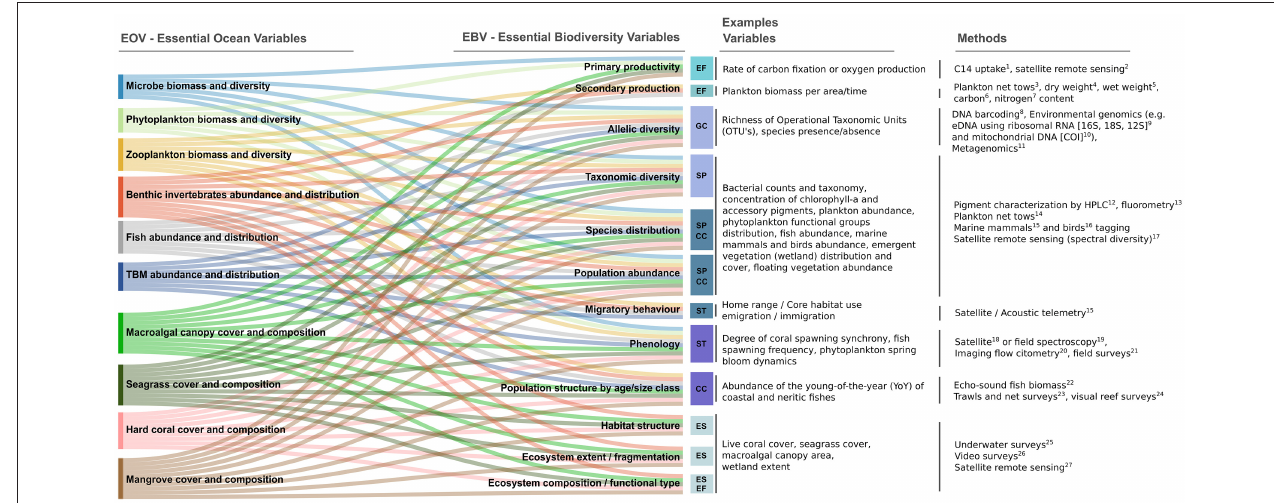
FIGURE 1 | Conceptual relationship between EOVs and EBVs, with simple examples. EOVs (listed on the left hand side) are broadly taxonomically focused around productivity at the base of the food chain (microbes, phytoplankton and zooplankton), higher trophic levels (benthic invertebrates; fish; TBM: marine turtles, birds, and mammals), and habitat forming species (macroalgae, seagrass, mangrove, coral). In contrast, example EBVs (listed on the left hand column) evaluate taxa across scales of spatial and temporal diversity within species (allelic diversity, species distribution, population abundance, population structure by age/size class, phenology), across species (taxonomic diversity), and in terms of ecological context (primary productivity, secondary productivity, habitat structure, ecosystem extent / fragmentation, ecosystem composition / functional type). EOVs are described in Miloslavich et al. (2018). EBV classes from Pereira et al. (2013) are shown as colored boxes which aggregate different example EBVs, specifically: GC, Genetic composition; SP, Species populations; ST, Species traits; CC, Community composition; ES, Ecosystem structure; EF, Ecosystem function. EBVs on primary/secondary production are directly associated with the microbe, phytoplankton, zooplankton, and fish EOVs. Other EBVs can be applied more broadly to the rest of the EOVs. References for the methods listed on the right-hand column of the diagram are as follows: 1 Holm-Hansen and Riemann (1978); Knap et al. (1997); 2 Behrenfeld and Falkowski (1997); 3 Harris et al. (2000); 4 Madin et al. (2001); 5 Omori (1969); 6 Landry et